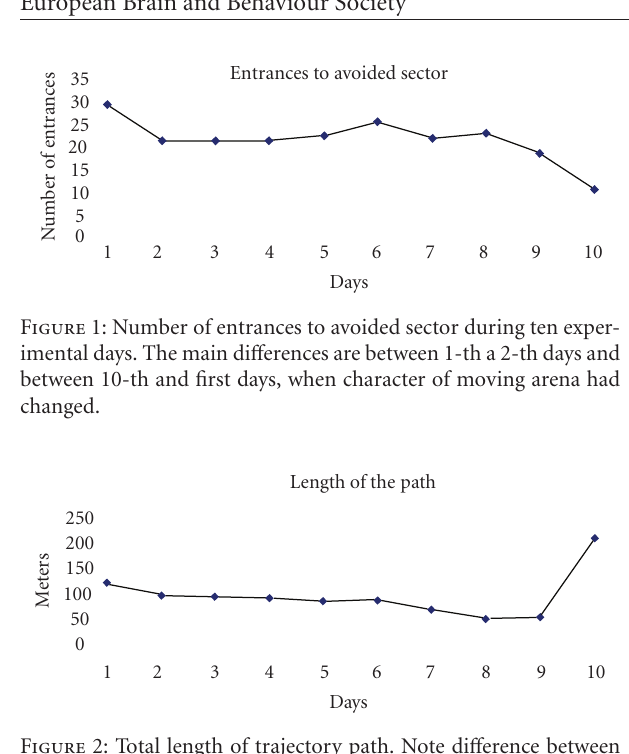
Figure 2: Total length of trajectory path. Note di ff erence between 10-th day when character of moving arena had changed and remain experimental